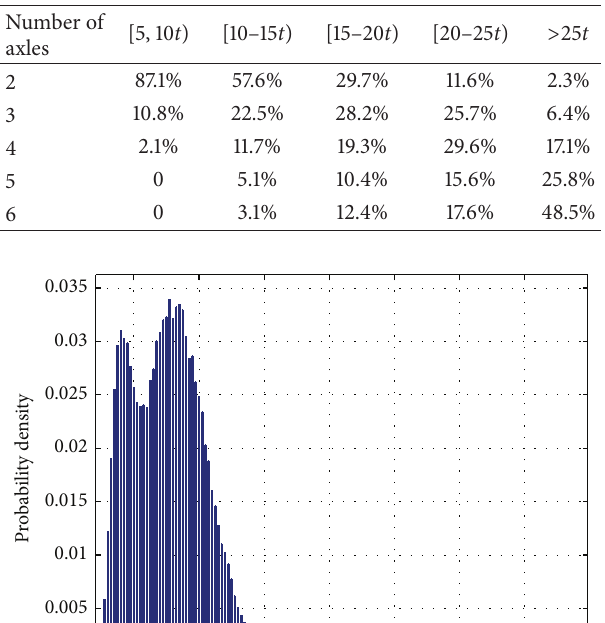
Table 3: Proportions of different vehicles in terms of different load intensities.